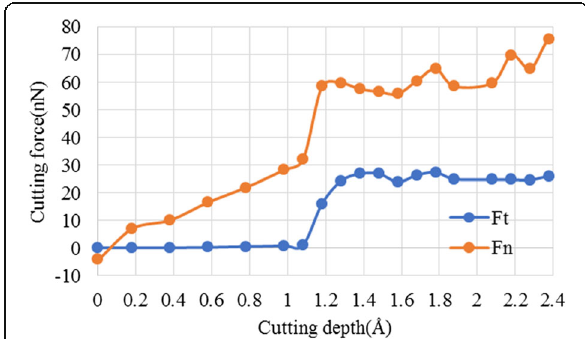
Fig. 13 Plot of cutting forces versus cutting depth at edge radius of 2 nm